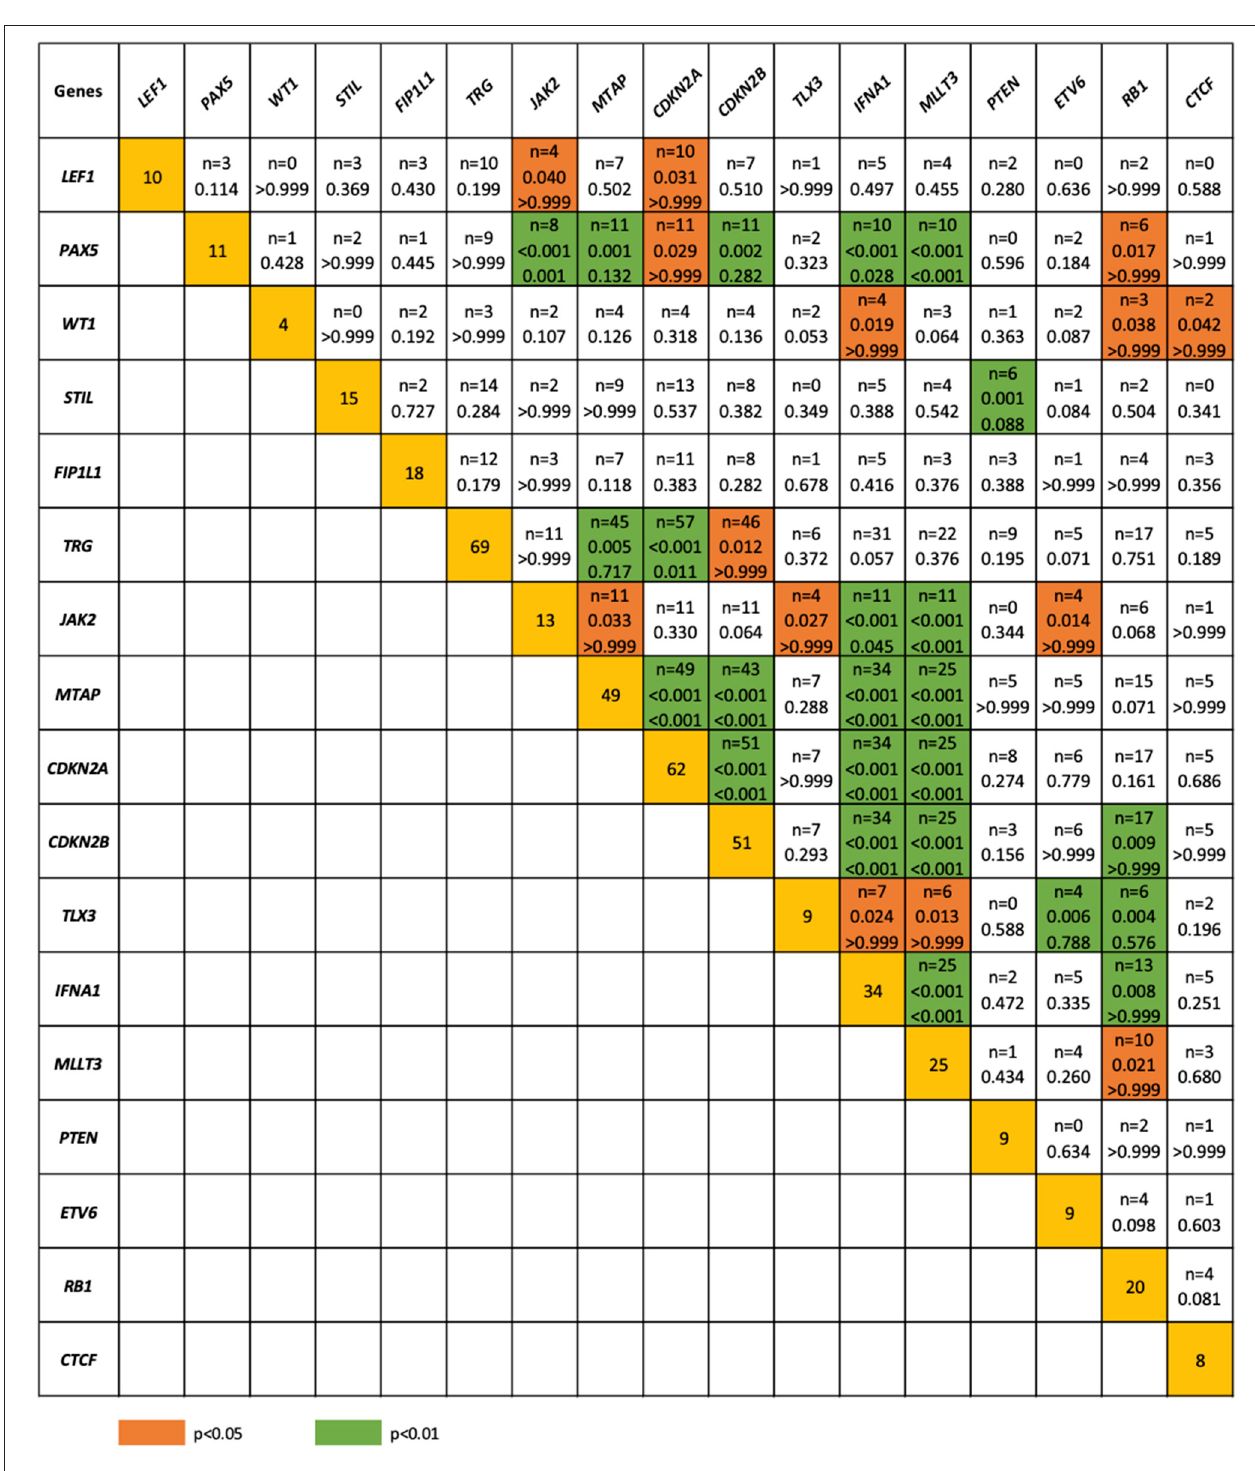
FIGURE 8 | Concomitance of gene deletions in 86 children with T-ALL. Yellow boxes indicate the total number of patients with a deletion. Other boxes indicate the number of patients with two specific abnormalities. Orange and blue colors indicate significant overlap associations in individual comparisons ( p < 0.01 or p < 0.05), respectively. If association in individual comparison of two genes was significant, p -value corrected for multiple comparisons was added.